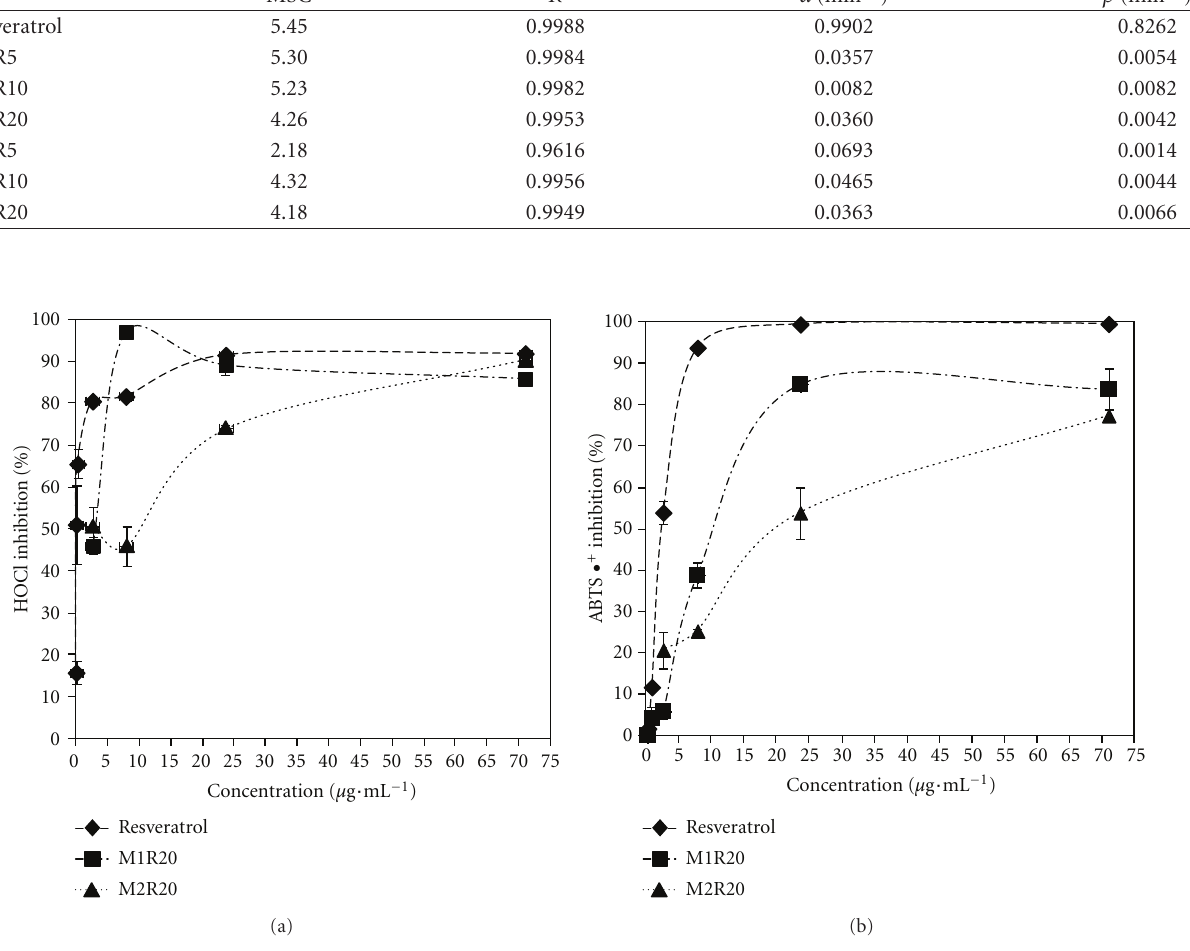
stages of entrance of water and drug release.